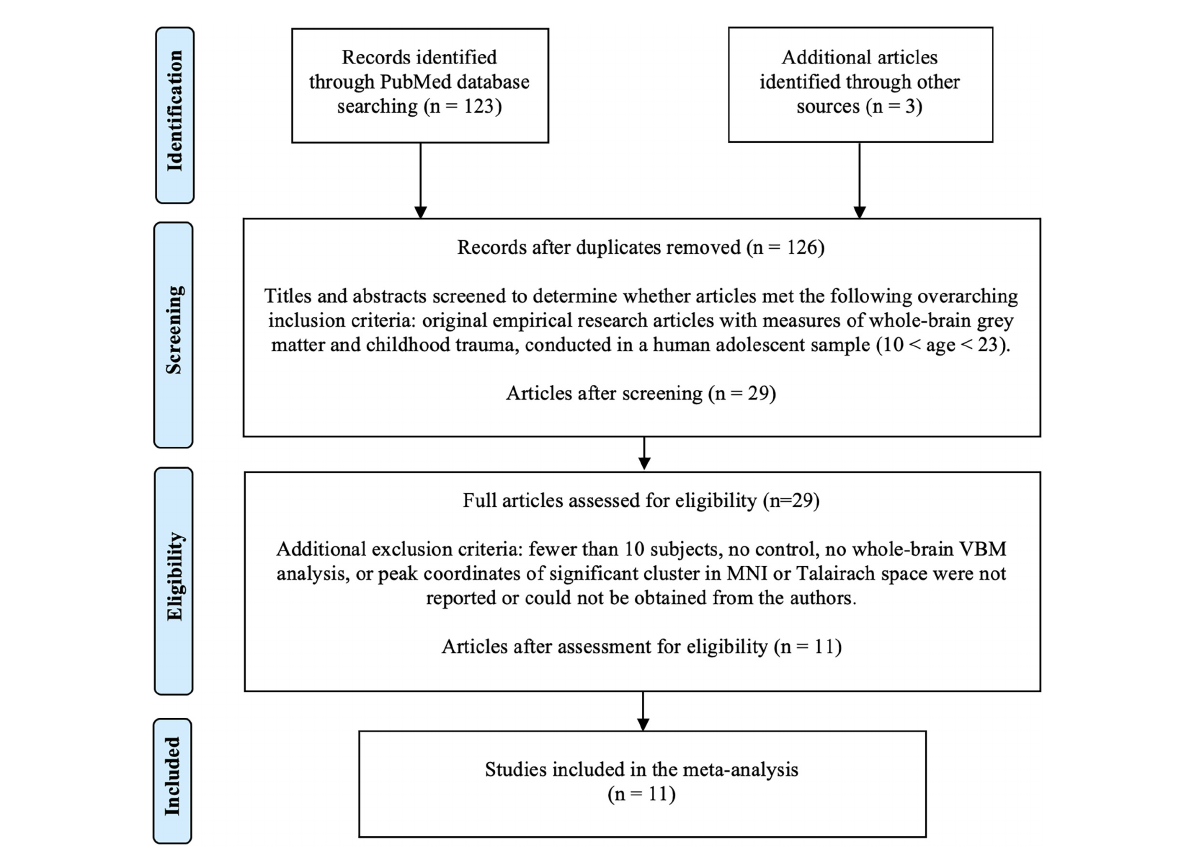
FIGURE1 Literature search flow using PRISMA guidelines (Moher et al., 2009). VBM, voxel-based